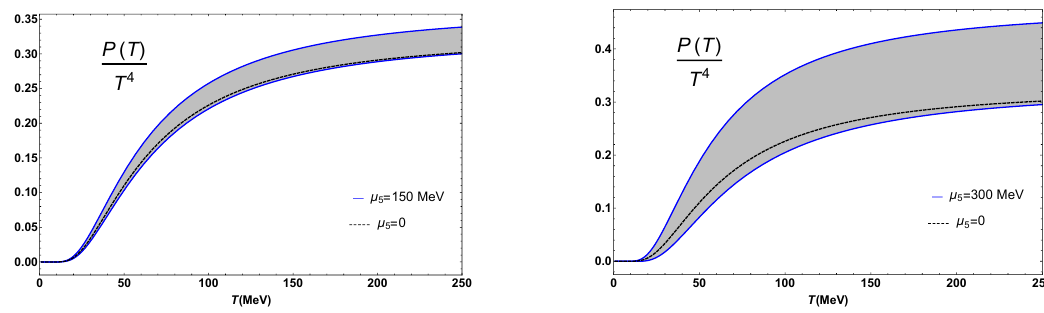
Figure 8 . Pressure for (cid:22) 5 = 150 MeV and (cid:22) 5 = 300 MeV compared to the (cid:22) 5 = 0 case. The uncertainty bands correspond to 0 (cid:20) (cid:20) 2 (cid:20) 1